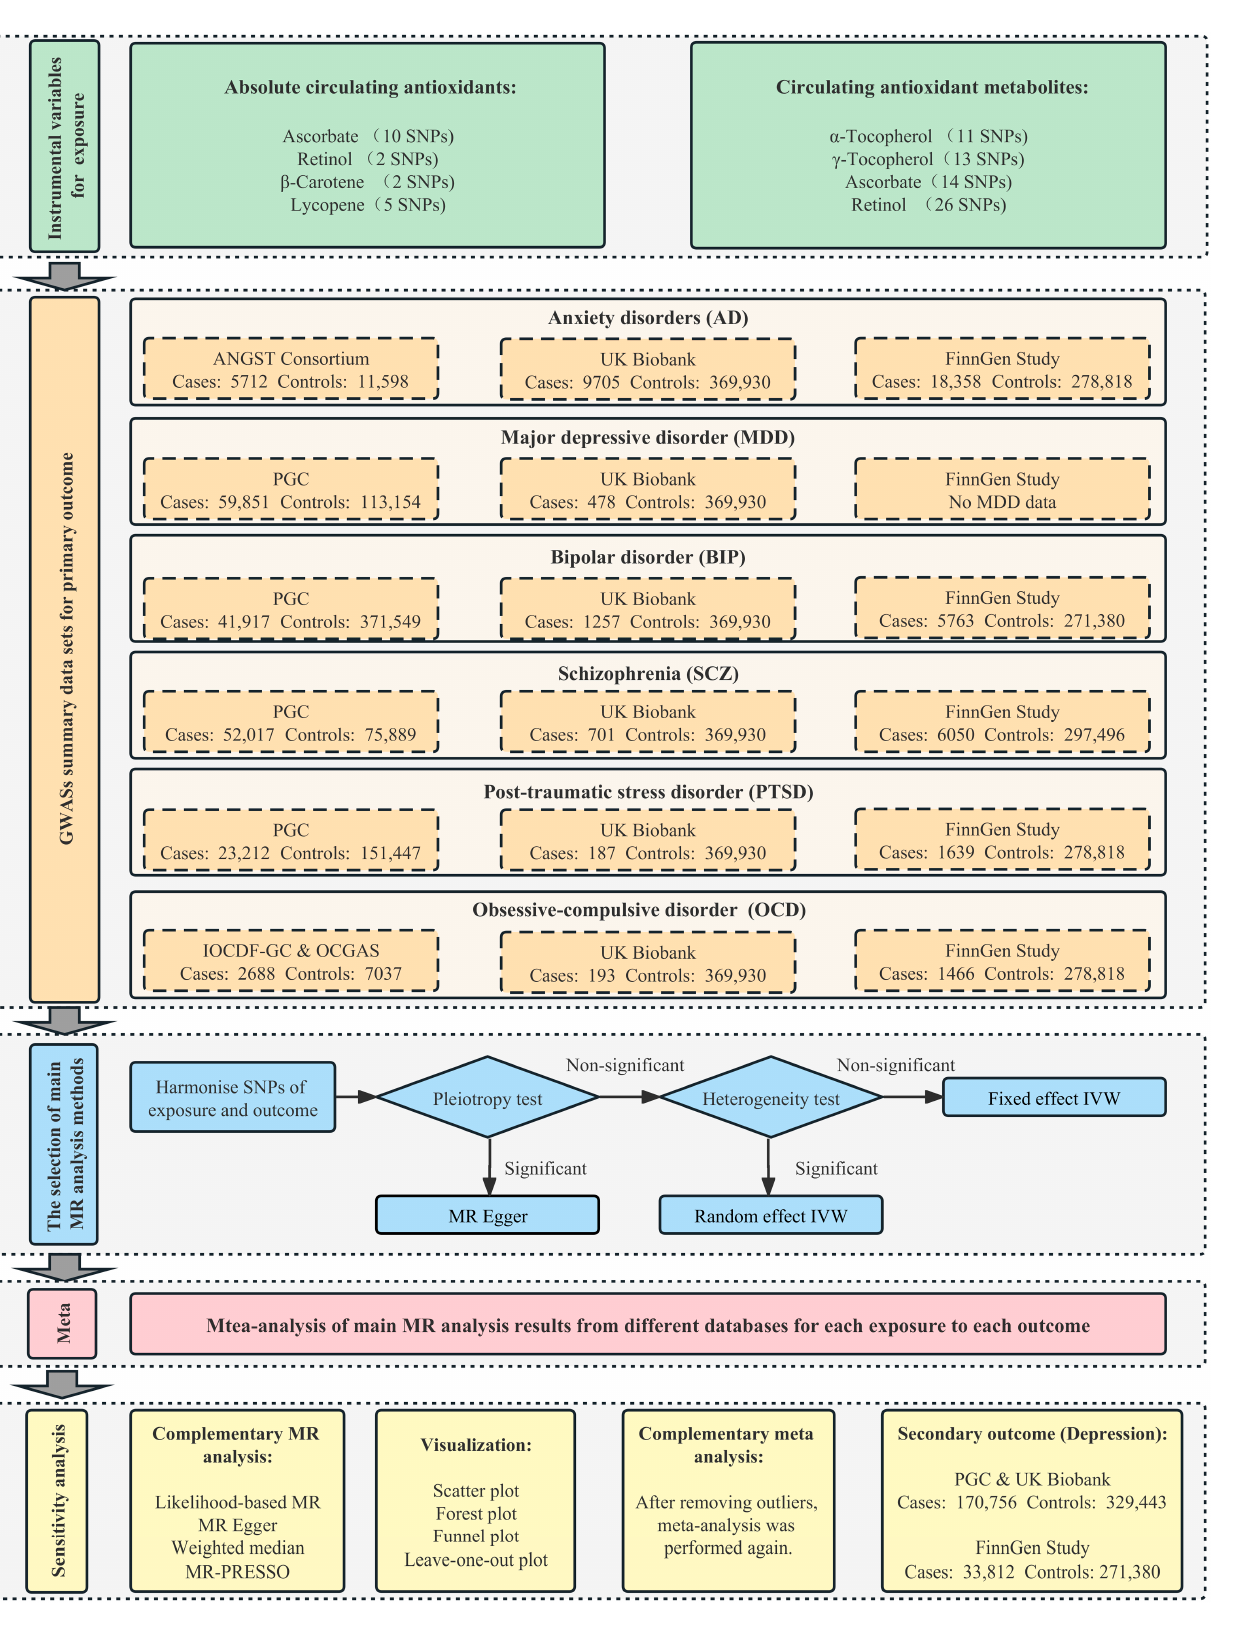
Figure 1. Schematic overview and framework of the present MR study design. Abbreviations: SNP, single-nucleotide polymorphism; MR, Mendelian randomization; PGC, Psychiatric Genomics Consortium; IVW, inverse-variance weighted; MR PRESSO, MR Pleiotropy RESidual Sum and